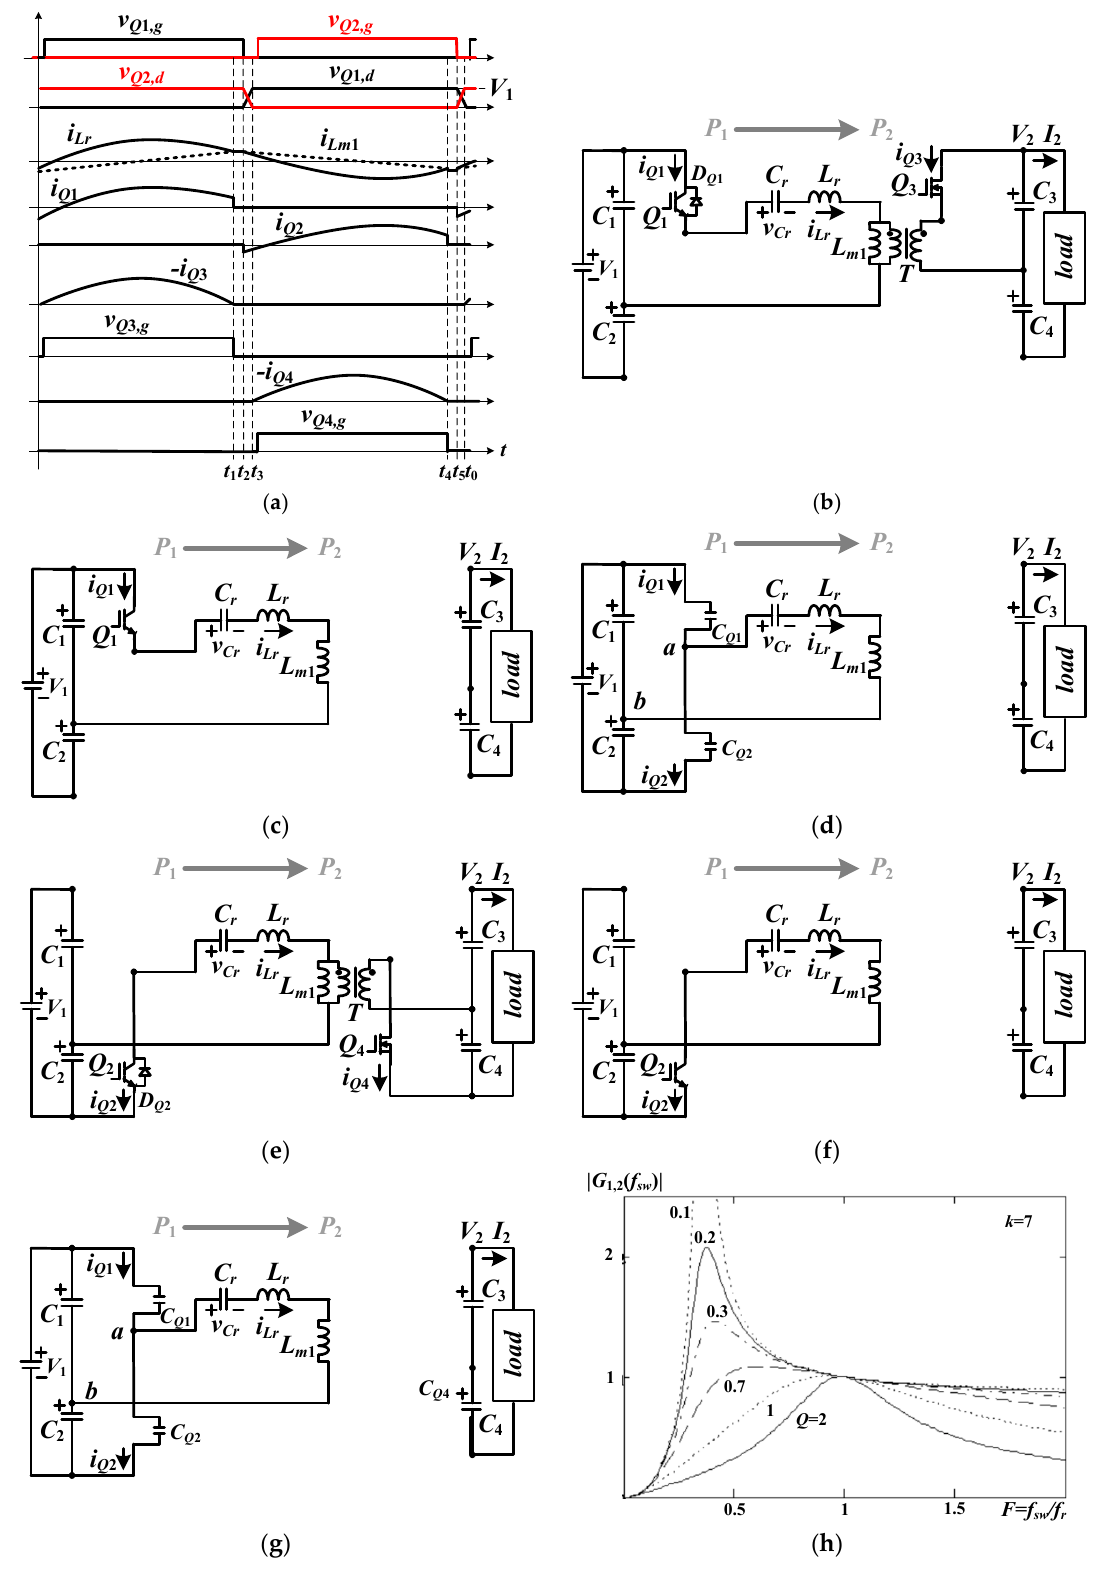
Figure 3. Pulse-width modulation (PWM) waveforms, stage operations, and gain curve under forward power flow: ( a ) PWM waveforms; ( b ) Stage 1; ( c ) Stage 2; ( d ) Stage 3; ( e ) Stage 4; ( f ) Stage 5; ( g ) Stage 6; ( h ) gain curve of the studied circuit. Stage 1 ( t 0 ~ t 1 ): The output voltage of C Q 1 is decreased to zero at t 0 . Therefore, the soft switching characteristic of Q 1 can be achieved after t 0 due to i Q 1 ( t 0 ) = i Lr ( t 0 ) < 0 and D Q 1 conducts. Since i Lr > i Lm 1